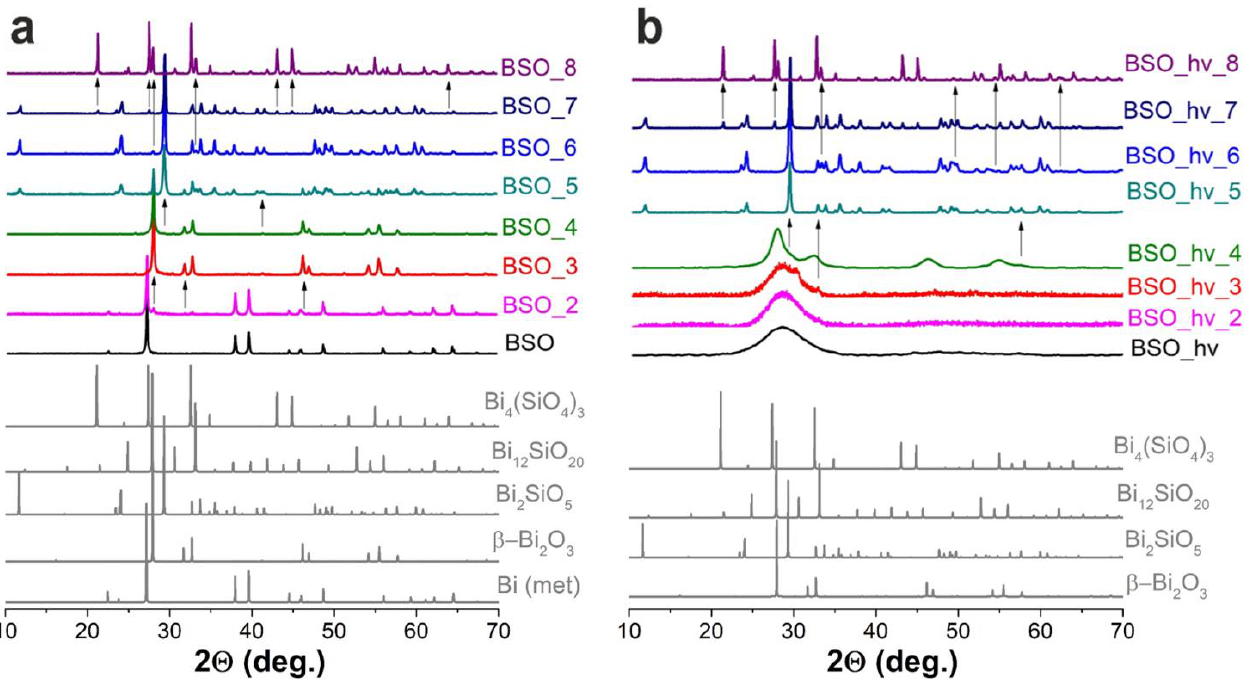
Figure 2. XRD patterns of non-irradiated samples BSO ( a ) and irradiated samples BSO_hν ( b ) before and after thermal treatment. Some evolution phase transitions are shown with arrows. PDF# base card numbers for known phases: 04-007-9968 (Bi); 04-015-6851 ( β -Bi 2 O 3 ); 00-036-0287 (Bi 2 SiO 5 ); 01-080-9154 (Bi 12 SiO 20 ); and 00-033-0215 (Bi 4 Si 3 O 12 ).